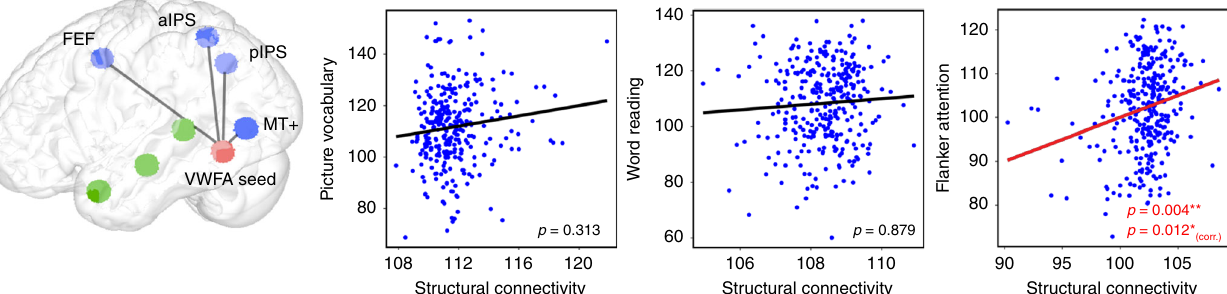
Fig. 4 VWFA circuits differentially predict language and visuo-spatial attention abilities across individuals. a Structural connectivity of VWFA with STS nodes (anterior, middle, and posterior STS) was signi fi cantly correlated with individuals ’ performance on picture vocabulary and word reading tasks, but not on the Flanker visuo-spatial attention task. b Structural connectivity of VWFA with fronto-parietal attention network nodes (FEF, aIPS, pIPS, and MT + ) was signi fi cantly correlated with individuals ’ performance on the Flanker attention task but not on the word reading or picture vocabulary tasks. Y -axis is age- adjusted performance scores on cognitive tasks and x-axis presents the predicted performance scores on cognitive tasks from the probability of structural connectivity of VWFA to either the language or the attention network